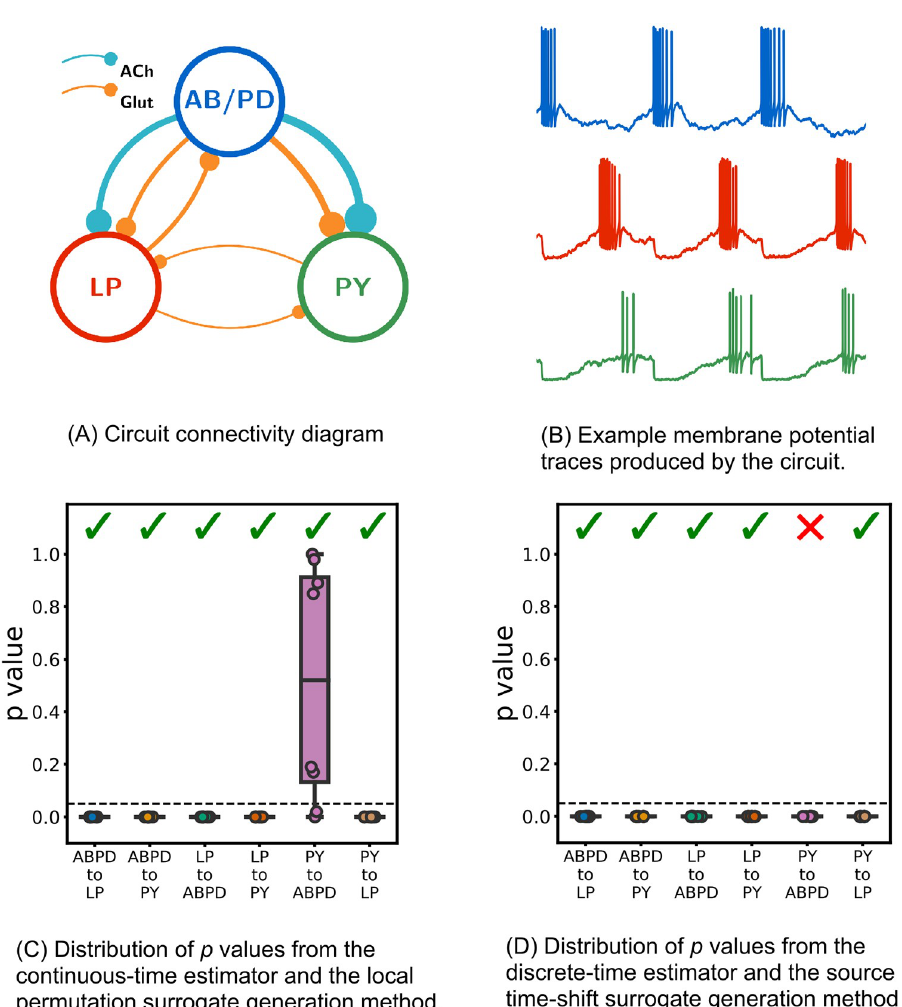
Fig 9. Results of both estimator and surrogate generation combinations being applied to data from simulations of a biophysical model of a neural circuit inspired by the pyloric circuit of the crustacean stomatogastric ganglion. The circuit, shown in (A), is fully connected apart from the missing connection between the PY neuron and the AB/ PD complex, and generates membrane potential traces which are bursty and highly-periodic with cross-correlated activity. The distribution of p values from the combination of the continuous-time estimator and local permutation surrogate generation scheme are shown in (C). They demonstrate that this combination is capable of correctly identifying the conditional dependence and independence relationships in this circuit in all runs, apart from two false negatives. By contrast, the distribution of p values produced by the combination of the discrete-time estimator and the traditional source time-shift surrogate generation method shown in (D) mis-specified the relationship from the PY to the ABPD in every run. Ticks represent the particular combination of estimator and surrogate generation scheme making the correct inference of dependence or independence in the majority of cases when a cutoff value of p = 0.05 is